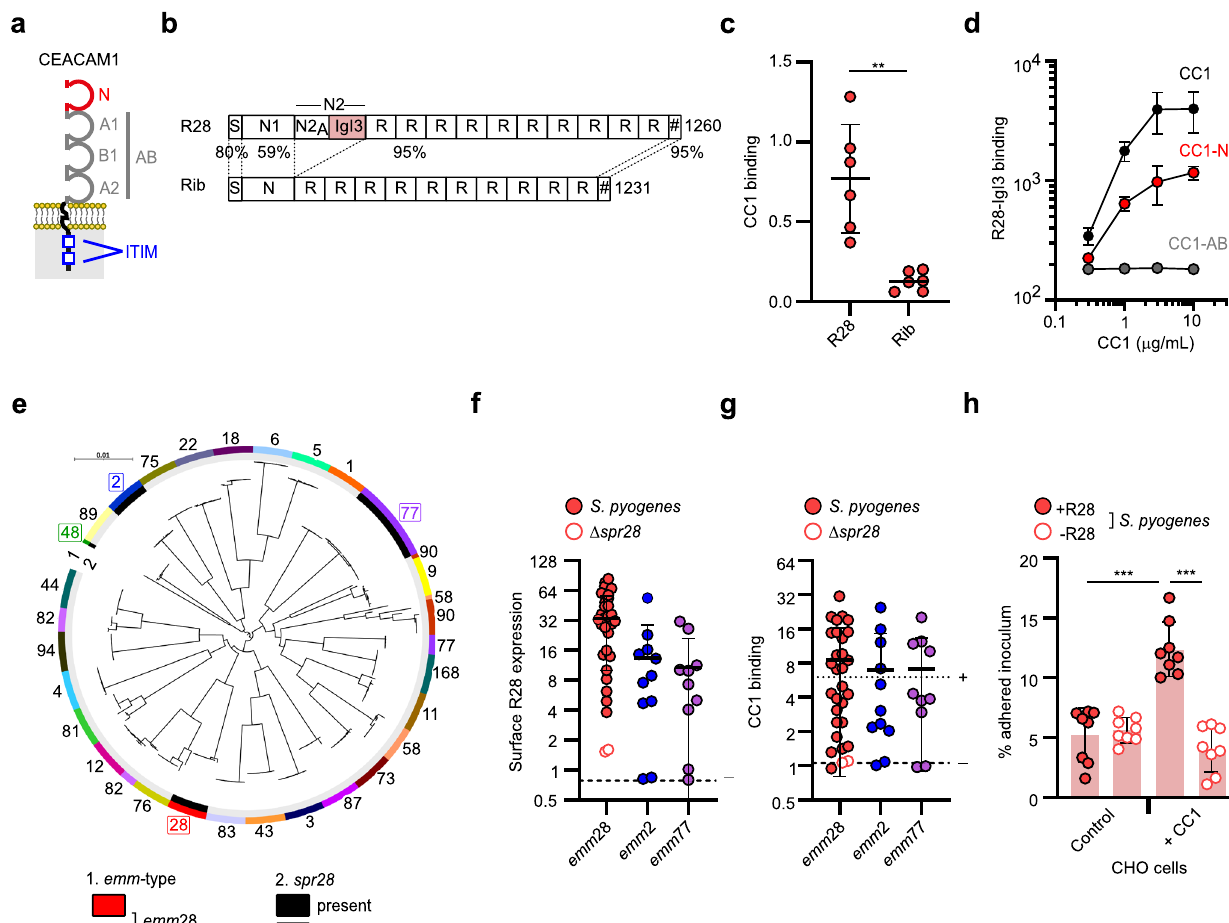
Fig. 1 | The R28 adhesin of puerperal sepsis S. pyogenes isolates interacts with CEACAM1. a Schematic of CEACAM1 (CC1), containing the extracellular region (composed of four Ig-like domains termed N, A1, B1, and A2) and cytoplasmic tail containing two immunoreceptor tyrosine-based inhibitory motifs (ITIM) for sig- naling. b Schematic of the S. pyogenes R28 and S. agalactiae Rib proteins. Each protein has a signal peptide (S) and cell wall anchor (#) domains. R28 contains the N2 domain that can be divided into N2 A and N2 B (renamed IgI3) subdomains. The percentage residue identity between domains is indicated. c Binding of recombi- nant(r)CC1-FctoimmobilizedR28andRib,quanti fi edbyELISA(mean±s.d.of n =3 independent experiments). Statistical signi fi cance tested by two-tailed paired Student ’ s t test(** p =0.0079). d BindingofrCC1-HISvariantstoR28-IgI3,quanti fi ed by fl ow cytometry (mean±s.d. of n =6 independent experiments) e Core genome phylogenyof287representative S.pyogenes genomes. spr28 positivity(innercircle)